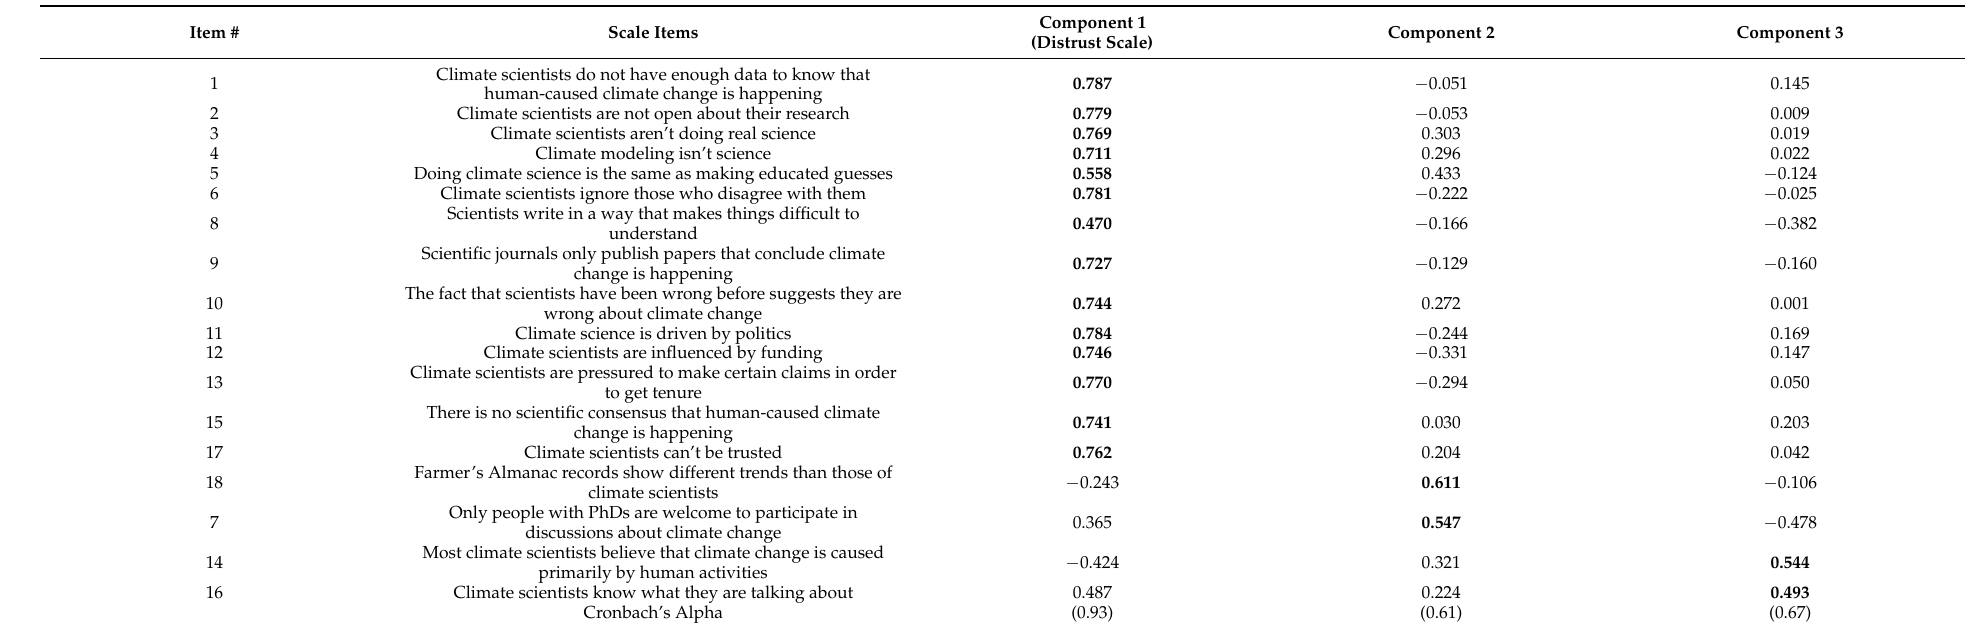
Table 3. Rotated component matrix from factor analysis with construct